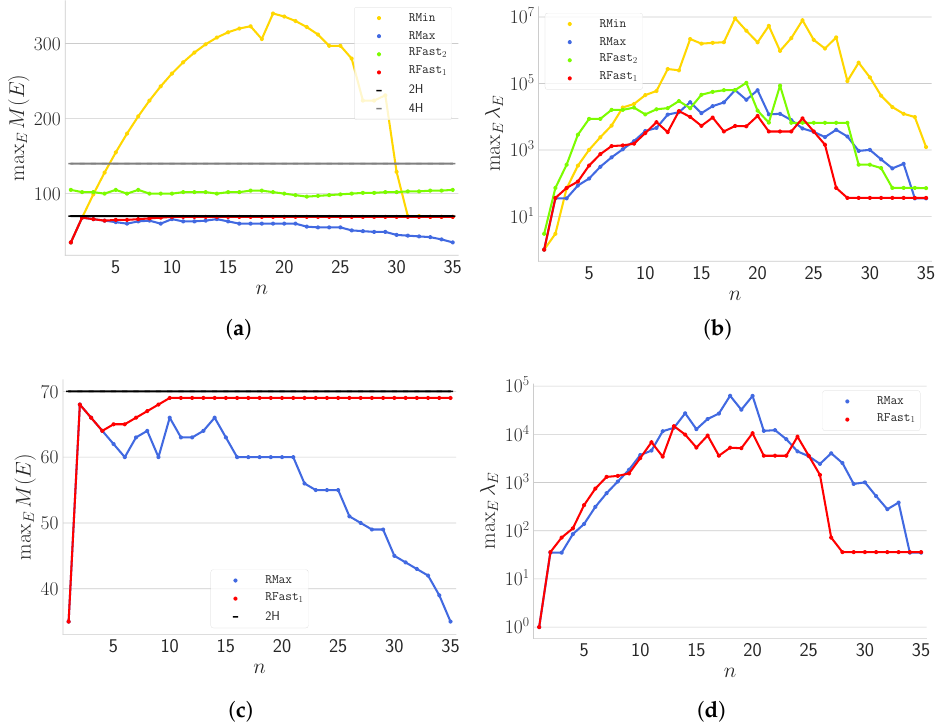
Figure 4. Experiments conducted on all possible ordered instances obtained by setting H = 35 and hence considering n varying in { 1,2, . . . ,35 } . Panels ( a , c ) refer to maximum M ( E ) , whereas panels ( b , d ) refer to maximum λ E . Panels ( c , d ) show strategies that, experimentally, exhibit